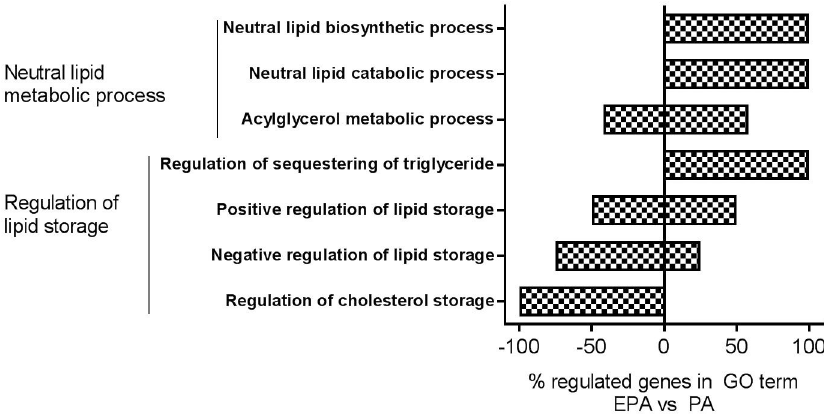
Fig 5. GO enrichment analysis. Myotubes were incubated with PA or EPA (100 μ M) for 24 h and then harvested for RNA isolation. Affymetrix human NuGO GeneChip arrays was used to measure gene expression and analysis performed in Partek Genomics Suite 6.6 software. GO enrichment analysis revealed that the GO terms”Neutral lipid metabolic process” (GO:0006638, upper 3) and”Regulation of lipid storage” (GO:0010883, lower 4) were changed significantly (p < 0.05) by EPA vs. PA. They are presented with % of genes up- or down-regulated in each child GO term and genes are presented in S1 Table. EPA, eicosapentaenoic acid; PA, palmitic acid.